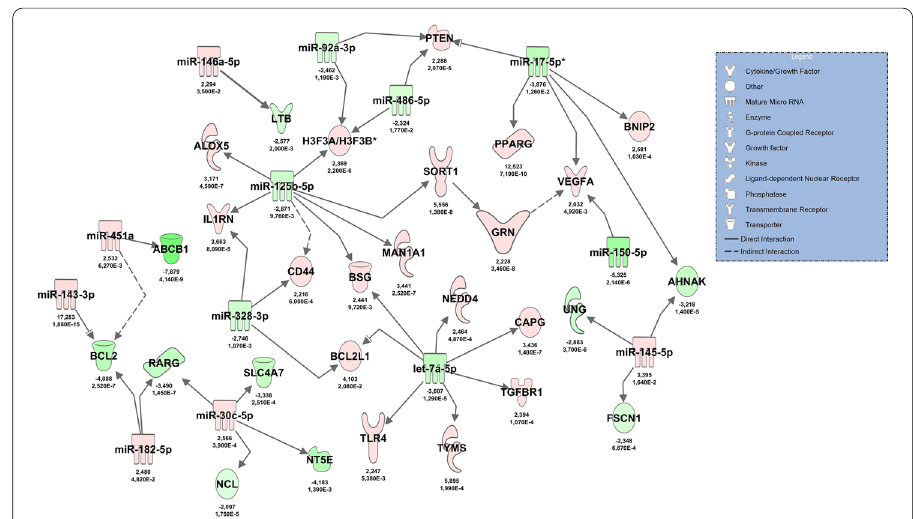
Fig. 10 Molecular network constructed from high‑throughput sequencing data showing progranulin activation during the early inflammatory response of immune cells during sepsis. Red color indicates upregulation in comparison to healthy volunteers, green indicates downregulation. Color shading corresponds to log 2 FC values. These values are indicated below the molecules along with FDR‑adjusted p ‑values. Molecules are shown as symbols in the network, and the molecule type is given in the